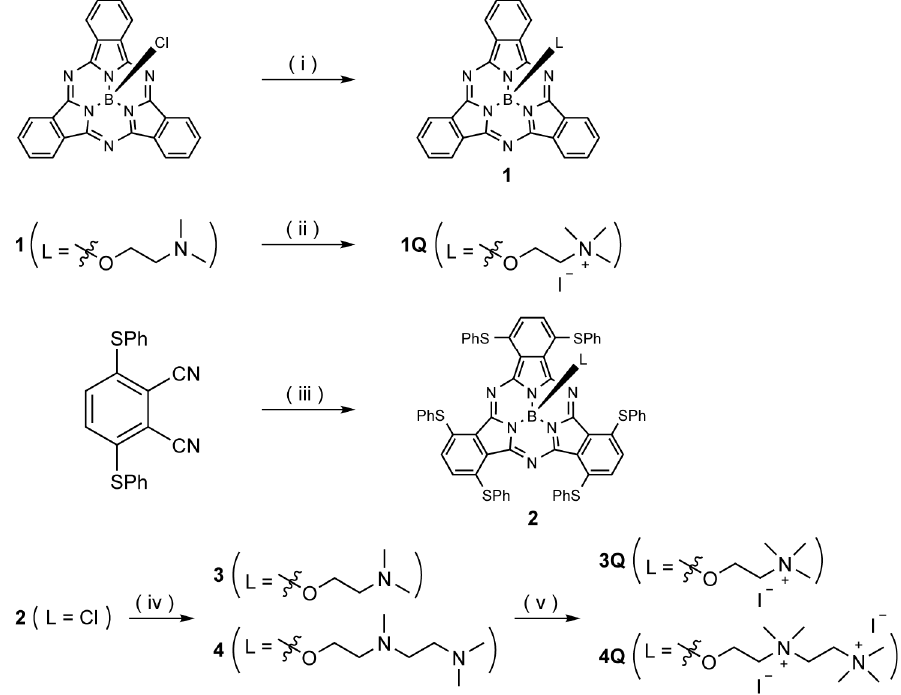
Scheme 1. Synthesis of subphthalocyanines (SubPcs). Reagents and conditions : ( i )